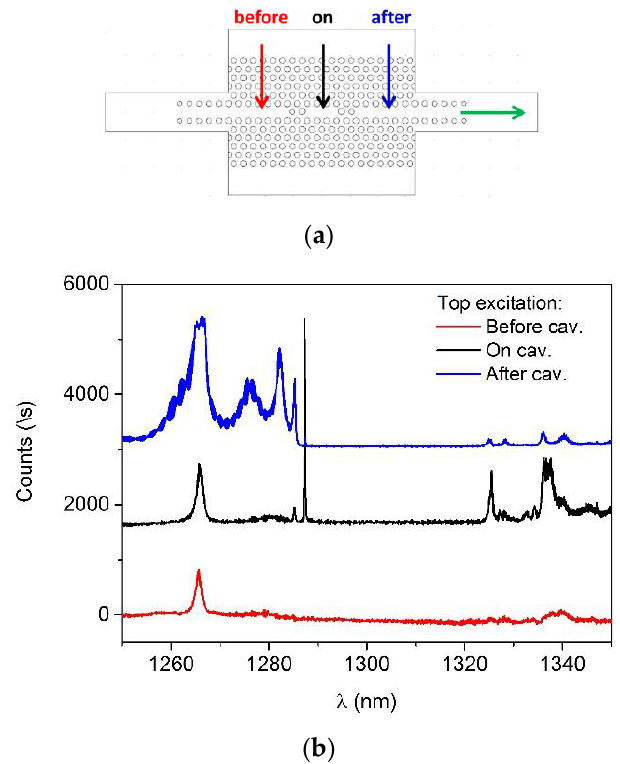
Figure 8. ( a ) Sketch of the design B filter: the red (before cavity), black (on cavity), and blue (after cavity) arrows indicate the different position of the top excitation, while the green the direction of the side collection. ( b ) PL spectra for the three different excitation positions with color coding corresponding to (a). The blue spectra has been reduced by a factor of 5 for greater clarity.